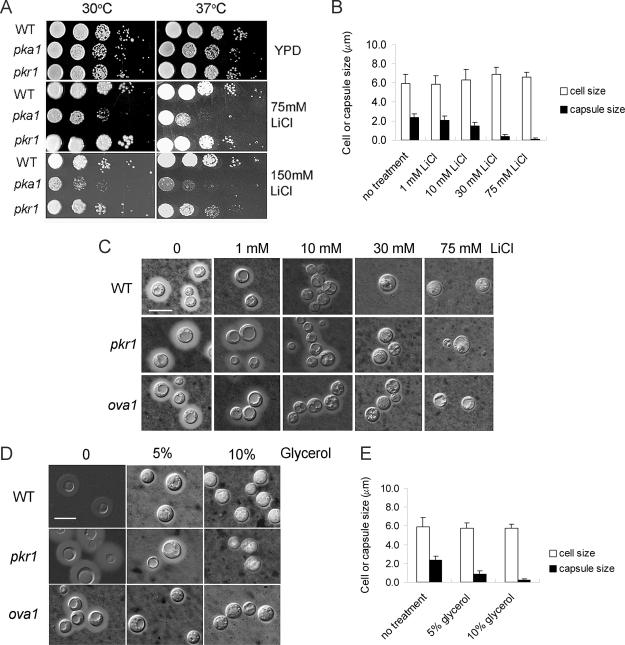
Lithium Chloride and Glycerol Treatments Influence Capsule Size(A) Sensitivity of the WT strain H99 and the pka1 and pkr1 mutants to growth on YPD medium containing LiCl. The strains are listed on the left side of the panel. The plates were incubated at 30 °C or 37 °C for 5 d before being photographed.(B) Sixty cells from the WT (H99) strain treated with LiCl at the indicated concentrations were measured for cell diameter and capsule radius. Each bar represents the average of measurements for 60 cells. The capsule sizes of the cells treated with 10, 30, and 75 mM LiCl were statistically different (p <0.001) from the sizes for the untreated cells.(C) Examination of capsule formation in the WT strain, and the pkr1 and ova1 mutants, in a range of LiCl concentrations. Bar = 10 μM.(D) Capsule formation in the WT and the pkr1 and ova1 mutants in the presence of glycerol at two concentrations (5% and 10%). Bar = 10 μM. In (B–D), cells were cultured in LIM at 30 °C for 16 to 72 h with addition of glycerol or LiCl as indicated.(E) Sixty cells from the WT (H99) strain grown with the indicated concentrations glycerol were measured for cell diameter and capsule radius. Each bar represents the average of 60 measurements. The capsule sizes of the cells with either concentration of glycerol were statistically different (p <0.001) from the sizes for the untreated cells.